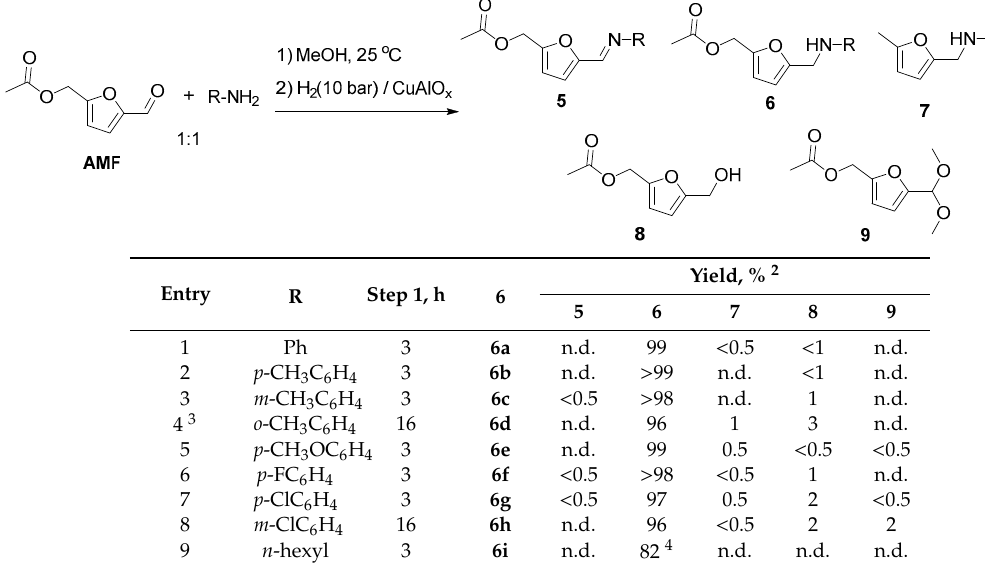
Table 3. Two-step one-pot reductive amination of 5-Acetoxymethylfurfural (AMF) with primary amines 1 .